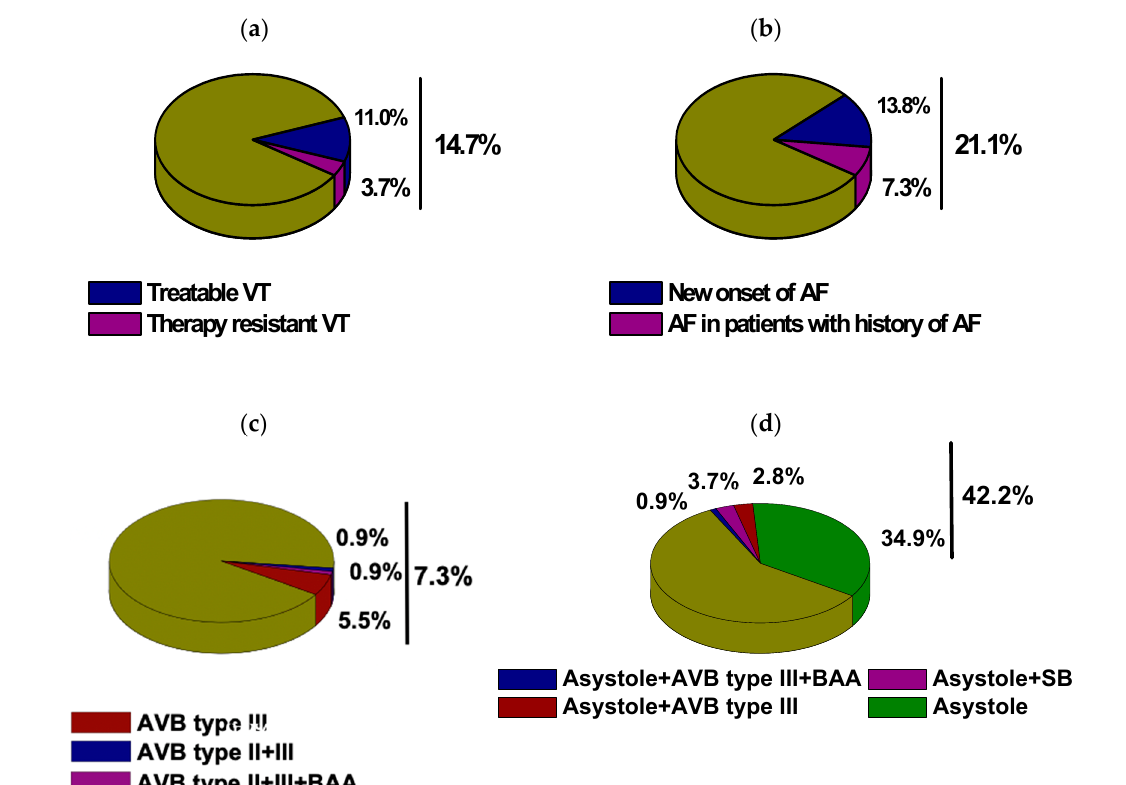
Figure 1. Characteristics of cardiac arrhythmias in sudden cardiac death (SCD) survivors treated with an Impella: ( a ) incidence of sustained VT, ( b ) incidence of atrial fibrillation (AF), ( c ) incidence of higher degree AV block II ◦ /III ◦ (AVB) type, ( d ) incidence of